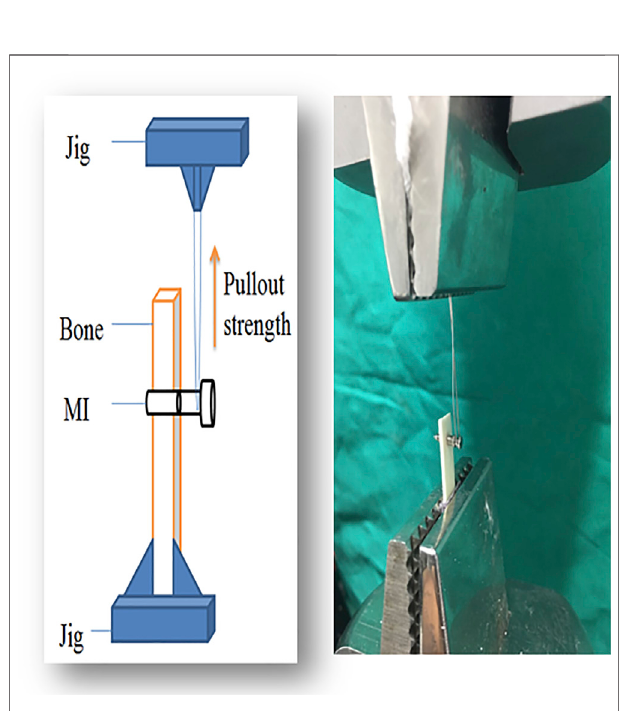
FIGURE 2 | The lateral pull-out strength testing system and the schematic